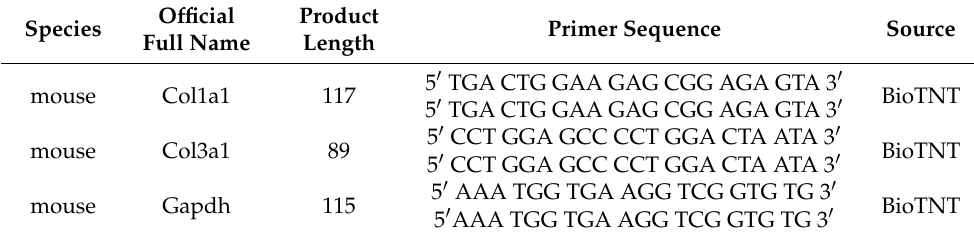
Table A1. Primer